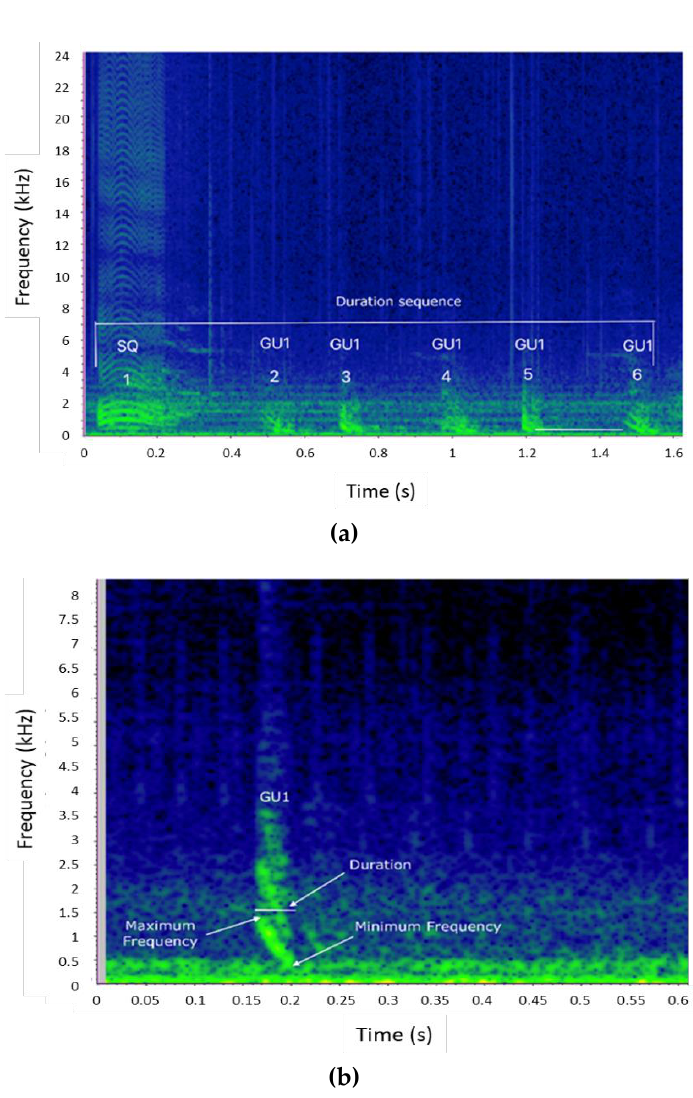
Figure 2 . (a) Spectrogram of a bray-call series indicating the parameters measured for the sequence (duration, type, and number of elements composing the sequence) and inter-element interval (period) (Hann window, size 2048, DFT 2048, overlap 50%, hop size 1024, sampling frequency 192 kHz, frequency resolution 93.75 Hz, analysis bandwidth 135 Hz at -3 dB). (b) Spectrogram of a single Gulp (GU) showing the acoustic parameters extracted for the element (Hann window, size 3000, DFT 4096, overlap 80%, hop size 600, sampling frequency 192 kHz, frequency resolution 46.875 Hz, analysis bandwidth 92.16 Hz at -3 dB).